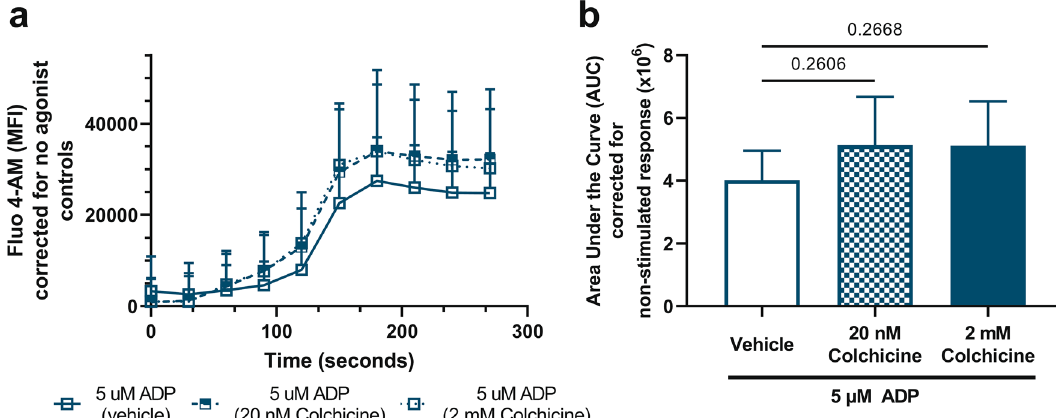
Figure 5. Colchicine does not alter ADP-induced calcium flux. Citrated PRP was used to assess the effect of colchicine on ADP-induced calcium flux by flow cytometry with Fluo-4 AM. ( a ) Calcium flux was not significantly altered in platelets pre-incubated with colchicine and stimulated with ADP (5 µM). Curves are corrected for the non-stimulated response. ( b ) Calcium flux was not significantly altered by 20 nM (p = 0.26) and 2 mM colchicine (p = 0.24)—area under the curve from ( a ). Statistical significance determined by Students t test; data presented as mean ± SD, n = 4 donors. The average of duplicate curves was used for each